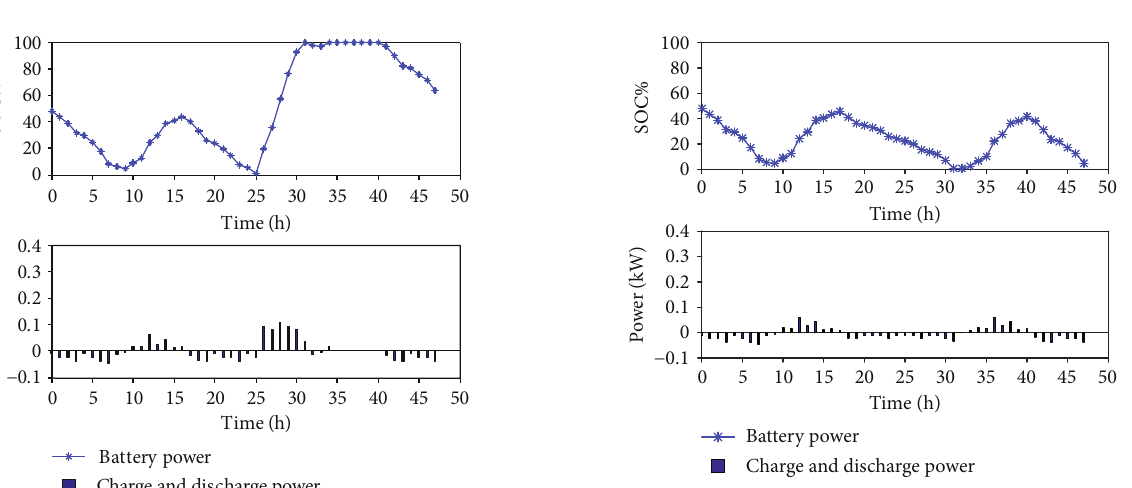
Figure 11: Battery charge state and 48h charge and discharge power (maximize energy usage with greedy selection strategies —— based on sleep mode